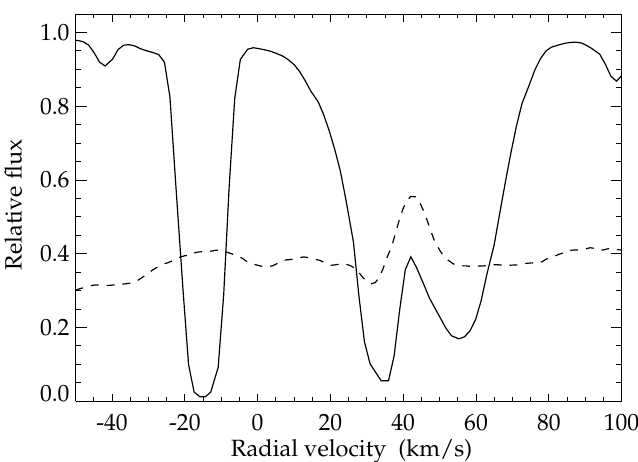
Fig. 12. The Na I D 2 -line in the NARVAL spectrum of R Sct on JD = 2454621.6 together with Ti I emission line at 8682.082 ˚A, with the intensity shift by –0.6. width of the blue-most Na I D 2 component is (cid:24) 0.3 mag, if that line is